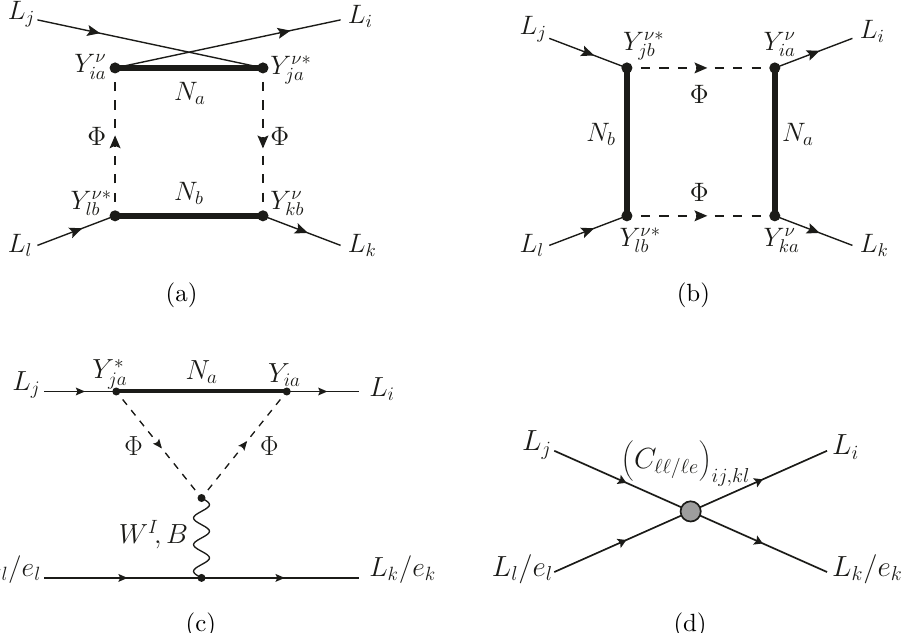
Figure 5. The double-Higgs boxes and the double-Higgs penguin are the only contributions to the loop-level matching onto O